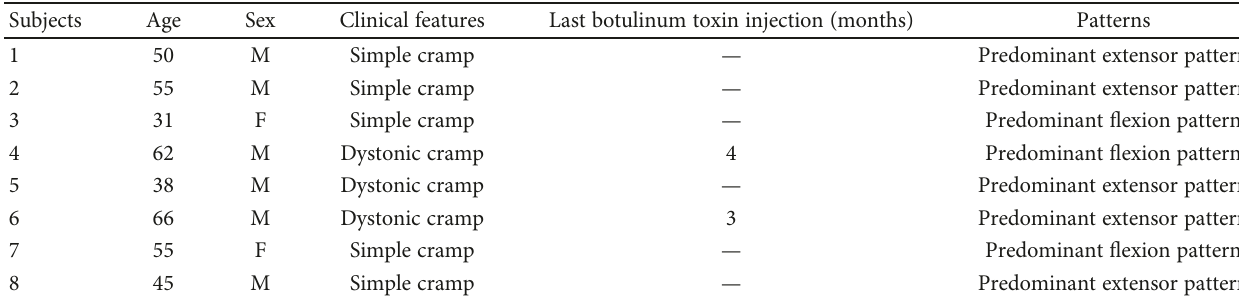
Table 1: Clinical